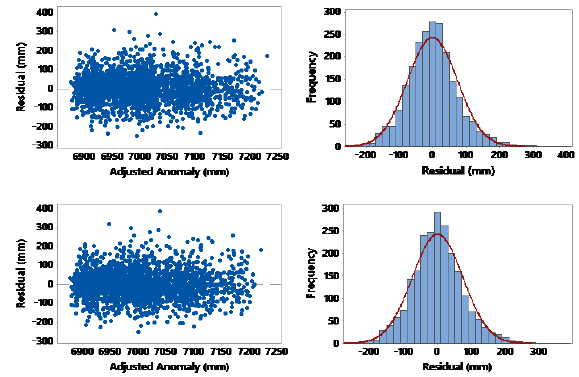
Fig. 2. Residual distributions for the uniform acceleration and trend model (top two plots) and uniform accleration with two-phase trend model. The residuals plotted against the adjusted height anoma- lies and histograms are indicative of their randomness, free from unmodeled systematic